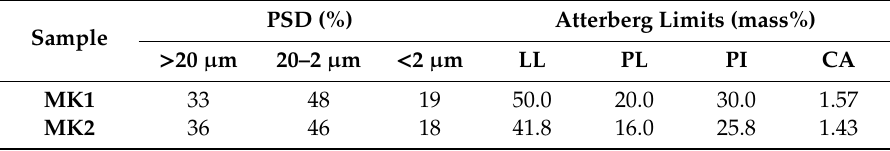
Table 1. Physical properties of raw clay